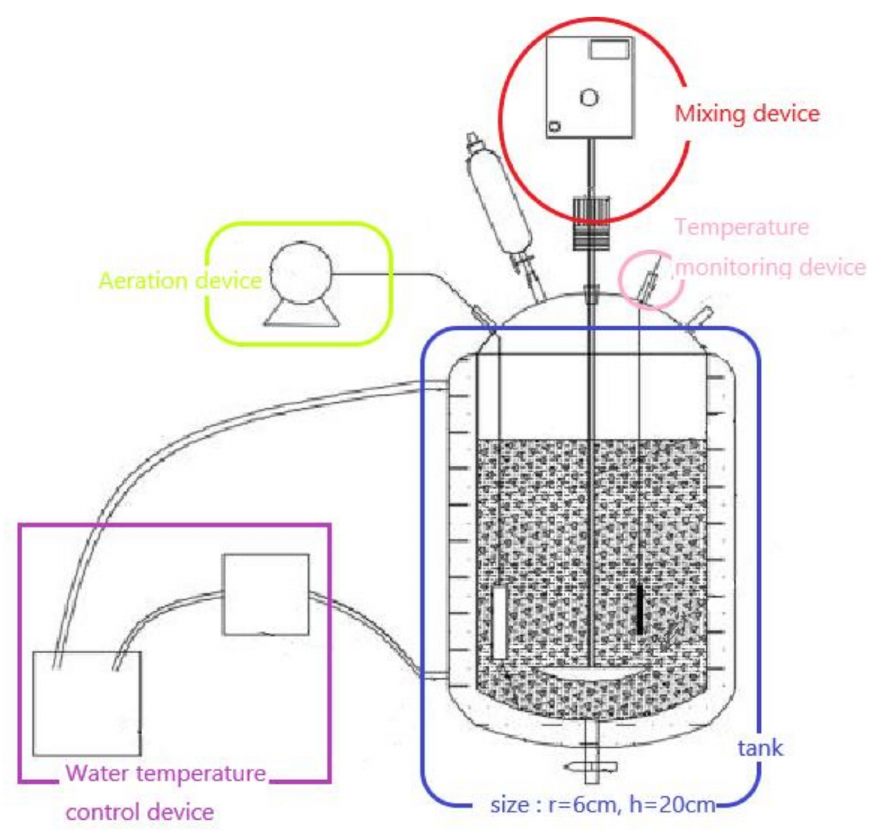
Figure 1. Aerobic slurry bioreactor in the